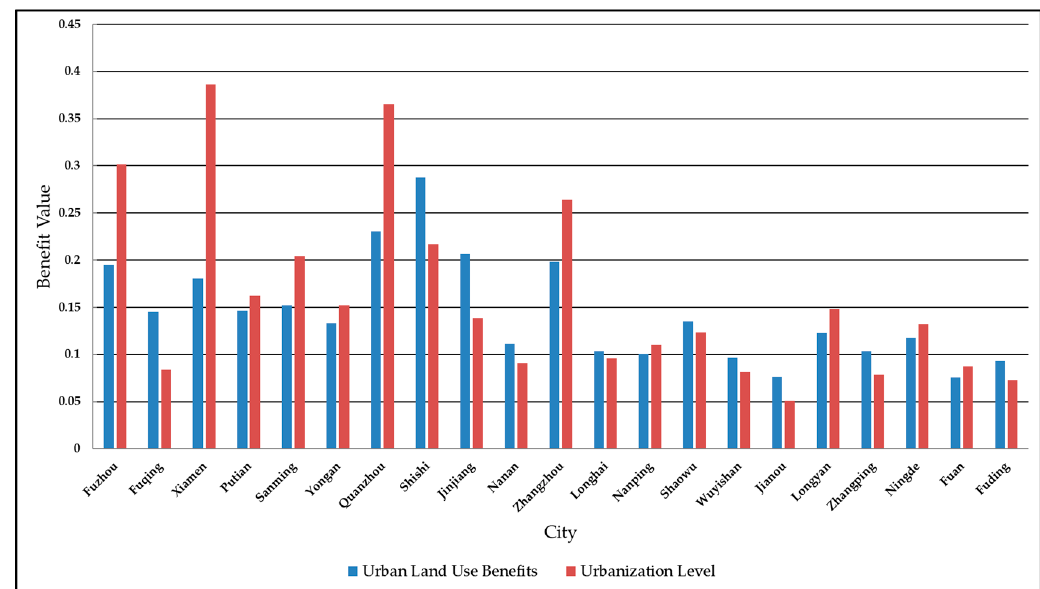
Figure 3. Comprehensive value of urban land use benefits and urbanization level by region in 2017.